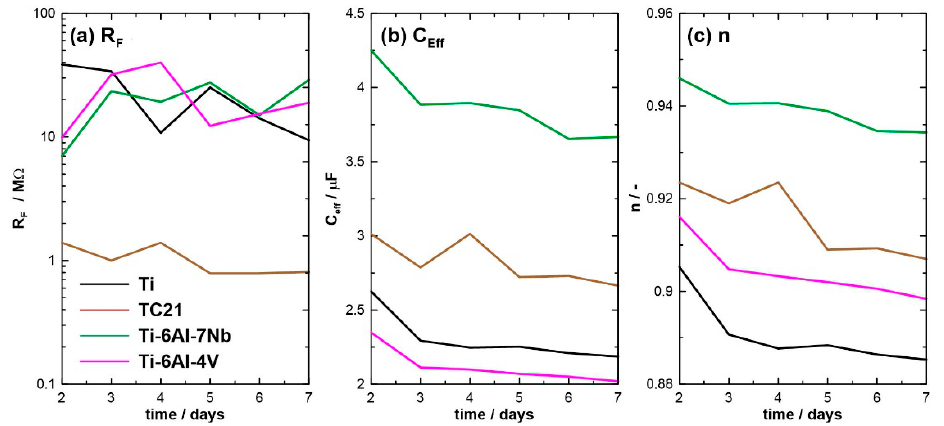
Figure 7. Monitoring of ( a ) passive layer resistance R F , ( b ) effective capacitance C eff and ( c ) CPE exponent n calculated on the base of R S (QR F ) EEC for each investigated alloy. The one-week exposure was carried out in 0.9% NaCl solution at 37 °C.